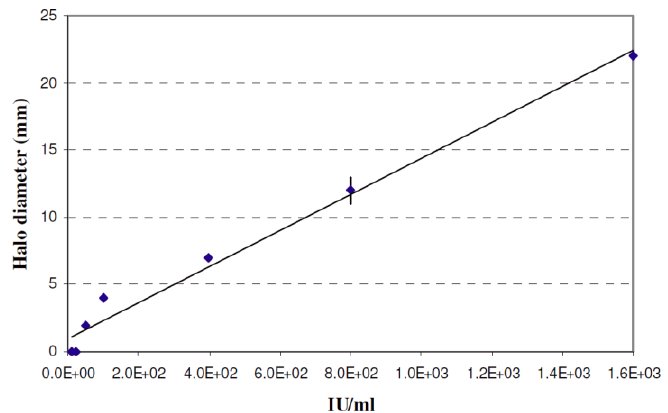
Figure 3. Halo diameters (mm) formed by nisin suspensions of different concentration (IU mL –1 ) in lawns of L. plantarum LZ used as indicator.